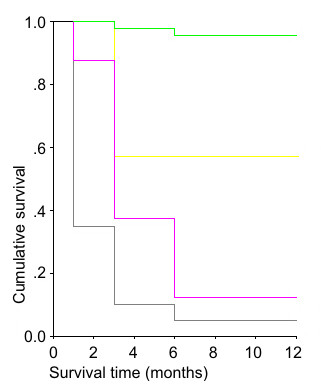
The joint effect of serum AHSG concentration and the MELD score on the survival of patients with alcoholic liver cirrhosis. Group 1 (green line): MELD < 20, serum AHSG ≥ 365 μg/ml (n = 46), group 2 (magenta line): MELD < 20, serum AHSG < 365 μg/ml (n = 16), group 3 (yellow line): MELD ≥ 20, serum AHSG ≥ 365 μg/ml (n = 7), and group 4 (grey line): MELD ≥ 20, serum AHSG < 365 μg/ml (n = 20), respectively. Compared to group 1, the survival is significantly shortened in groups 2, 3, and 4. Compared to group 1 the Odds Ratios for lethal outcome in groups 2, 3, and 4 are: 157.5 (95% C.I.: 20.28 – 1223, p < 0.001), 16.875 (95% C.I.: 2.149 – 132.5, p = 0.012), and 405.0, 95% C.I.: 34.53 – 4749 p < 0.0001), respectively.